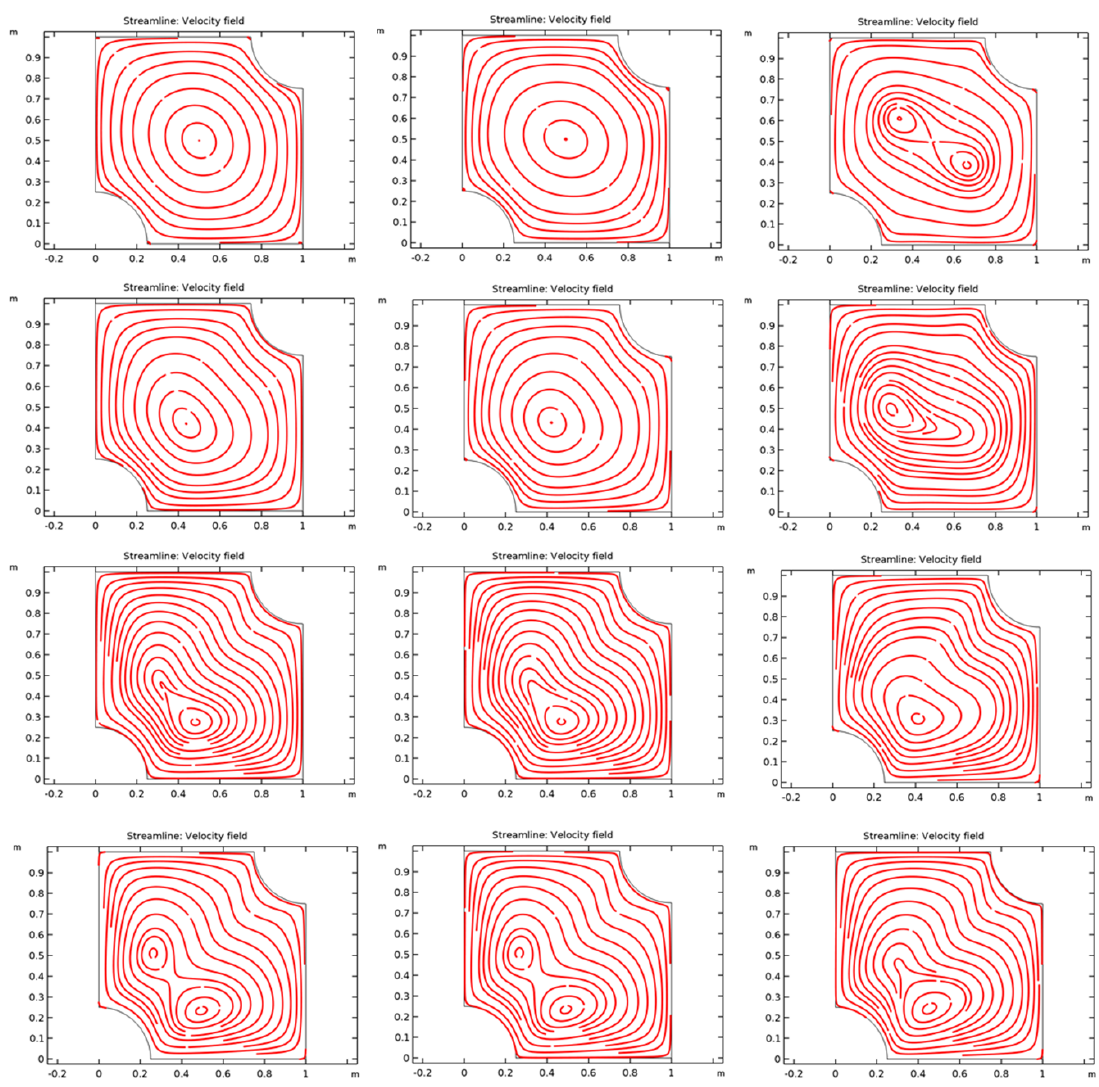
Figure 5. E ff ect of Hartmann number and Rayleigh number on the flow Figure 5. Effect of Hartmann number and Rayleigh number on the flow streamlines.